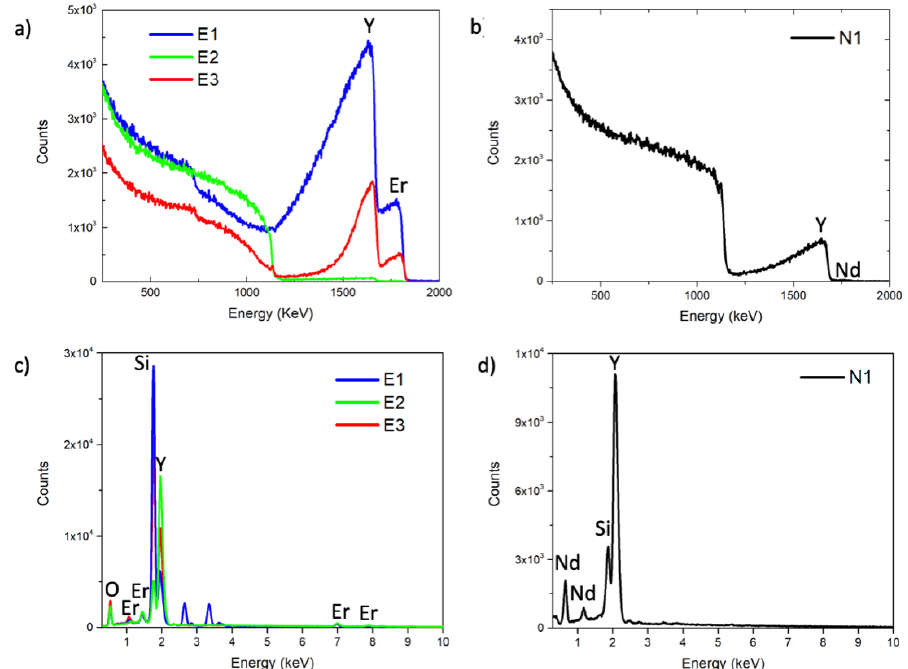
Figure 3. RBS spectra of ( a ) Er:Y 2 O 3 NPs samples E1, E2 and E3 and ( b ) Nd:Y 2 O 3 NPs sample N1. EDX spectra of ( c ) Er:Y 2 O 3 NPs samples E1, E2 and E3 and ( d ) Nd:Y 2 O 3 NPs sample N1.